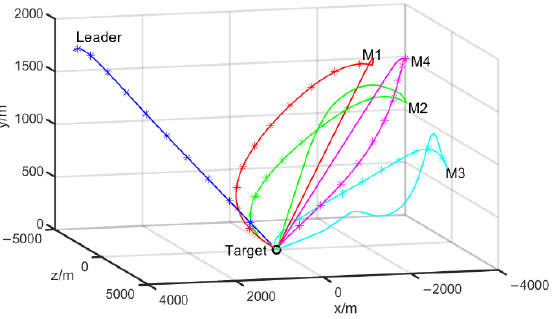
Figure 7. Flight trajectory curve of the cooperative attack on stationary target 1.